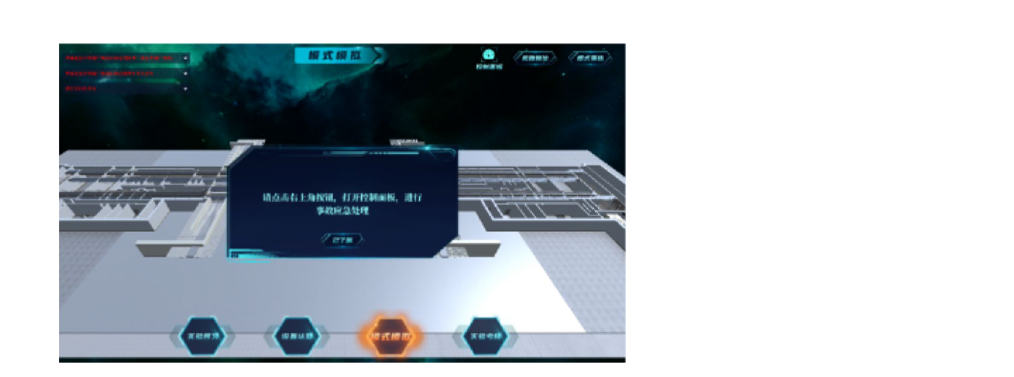
Figure 8. Path roaming.